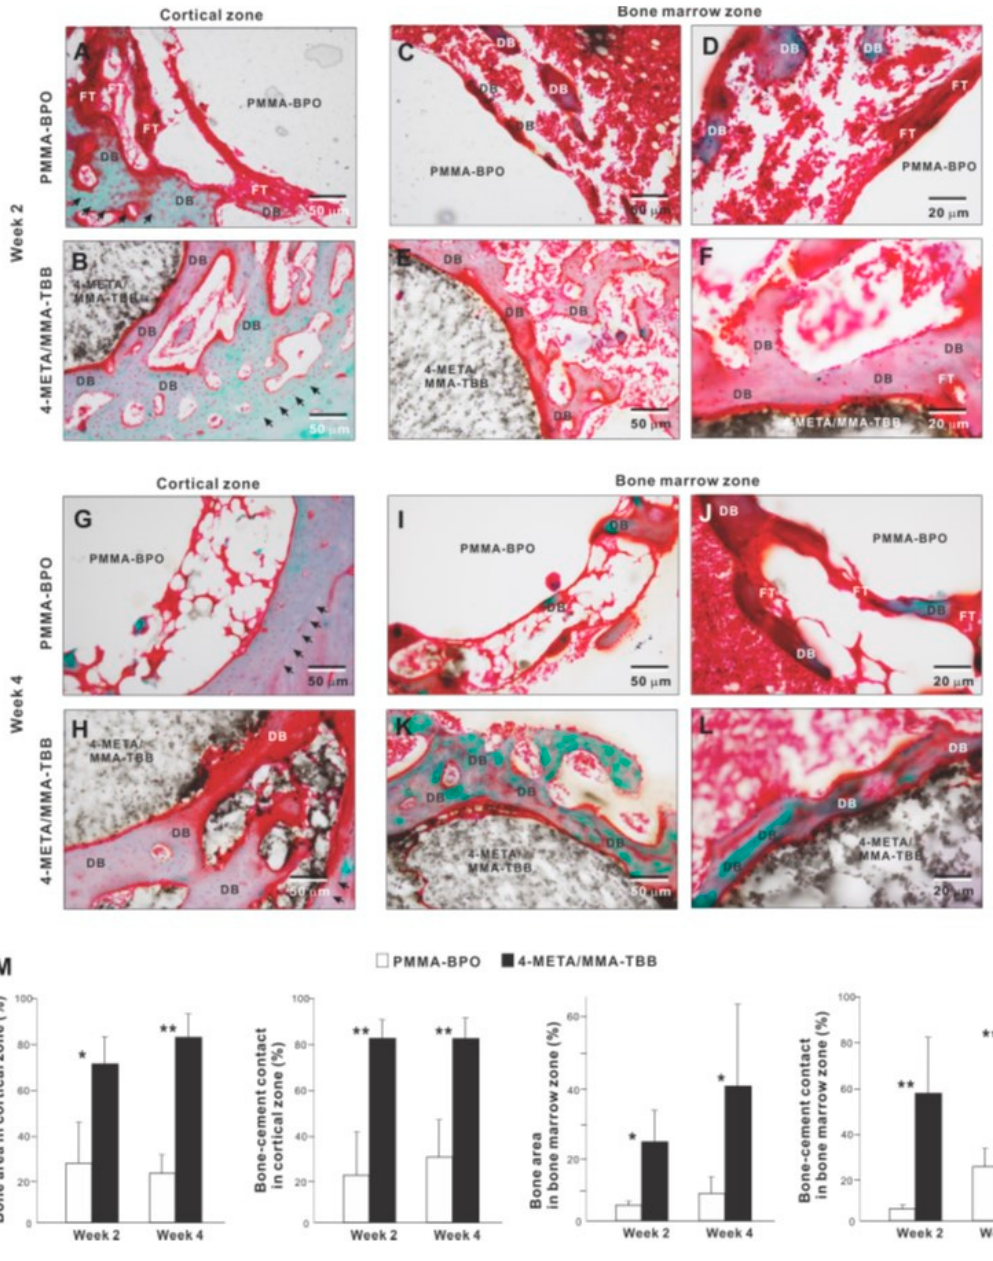
Figure 9. Peri-cement osteogenic morphology and morphometry around two different materials evaluated histologically at weeks 2 and 4 of healing. Representative histological images from week 2 ( A – F ) and 4 ( G – L ) are shown together with quantitative assessment of bone area and bone-cement contact ( M ). The qualitative and quantitative assessments were performed in both cortical and bone marrow zones. * p < 0.05, ** p < 0.01, statistically significant difference between the two materials. DB: de novo bone; FT: fibrous tissue.